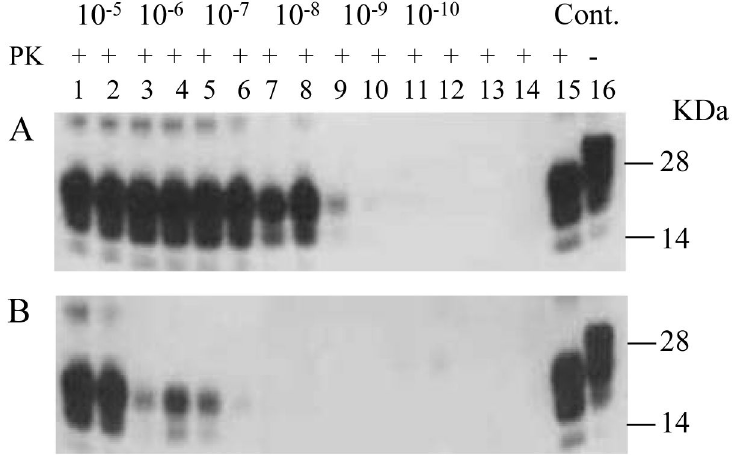
Figure 5. PMCA with and without beads in reaction tubes. Scrapie hamster (263K) brain material was diluted 10 -5 to 10 -10 in 10% hamster NBH and subjected to 1 round of PMCA with 3 beads added to each sample tube (Figure 5A) or without beads (Figure 5B). PMCA samples without seed are shown in lanes 13 and 14 in both panels. PMCA results are shown in lanes 1-12 with beads added (panel A) and without beads added (panel B). Scrapie hamster (263K) brain 1% homogenate was loaded in lanes 15-16 in both panels as positive controls (Cont.). Prior to electrophoresis, samples were digested with PK. The blots were stained with 6D11 antibodies. doi: 10.1371/journal.pone.0078710.g005 PrP TSE signals from higher dilutions were detected before of the tube in the sonicator or technical errors in dilutions. Most signals from lower dilutions. We investigated these likely this phenomenon is due to the fact that PrP TSE is observations and excluded being caused by either the position aggregated and not homogenously disperse and duplicate